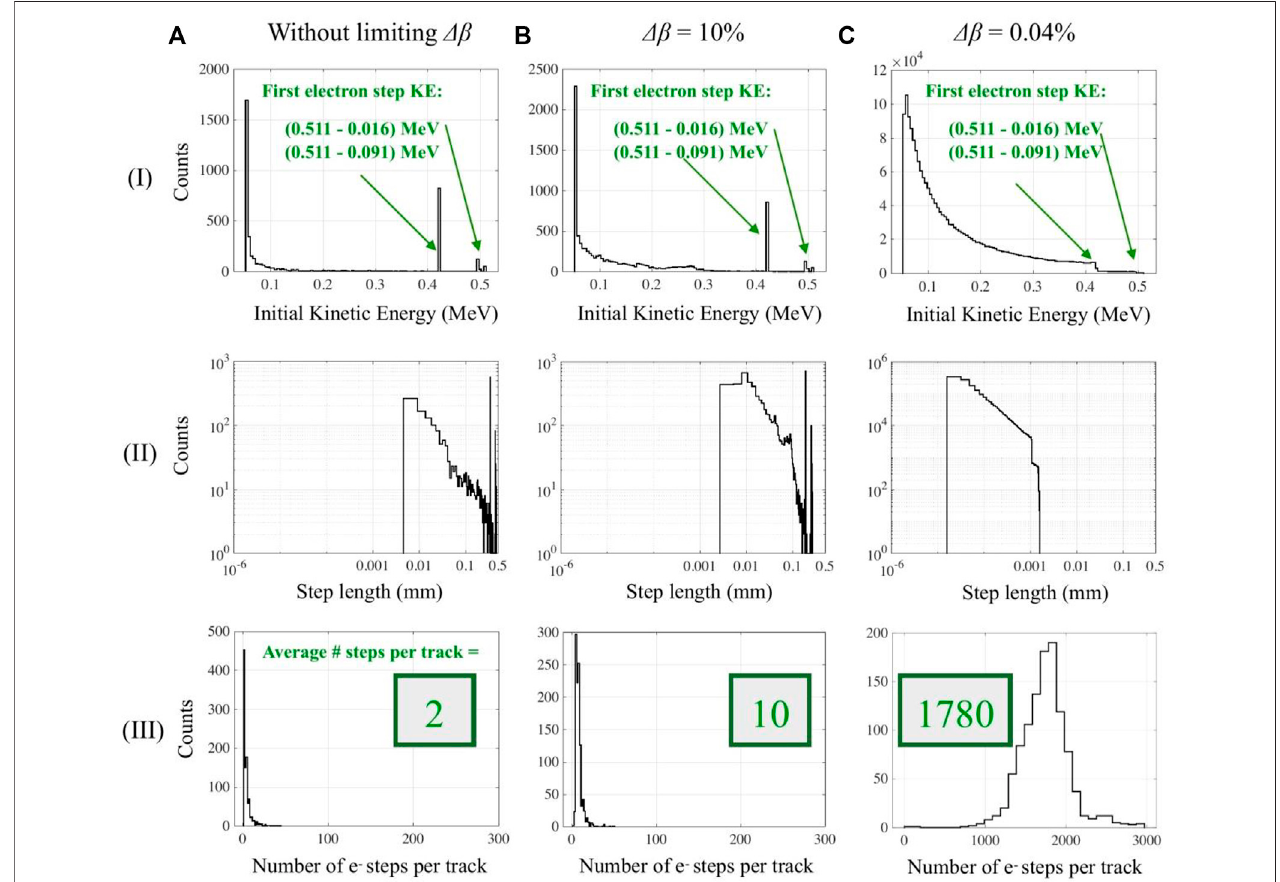
FIGURE 3 | (I) Electron initial kinetic energy at the beginning of each electron step, where the kinetic energy at the beginning of the very fi rst electron step is highlighted ingreen. (II) Electronsteplength(in log-log scale) and (III) number ofstep lengthsper track.Results areshown forall tracks and limiting themaximum change oftheelectronvelocityduringastep( Δβ ): (A) novalueof Δβ (defaultGeant4setting)isused, (B) alimitof10%or (C) 0.04%issetontheelectronvelocitychangeperstep. The y -axes scales are different in all fi